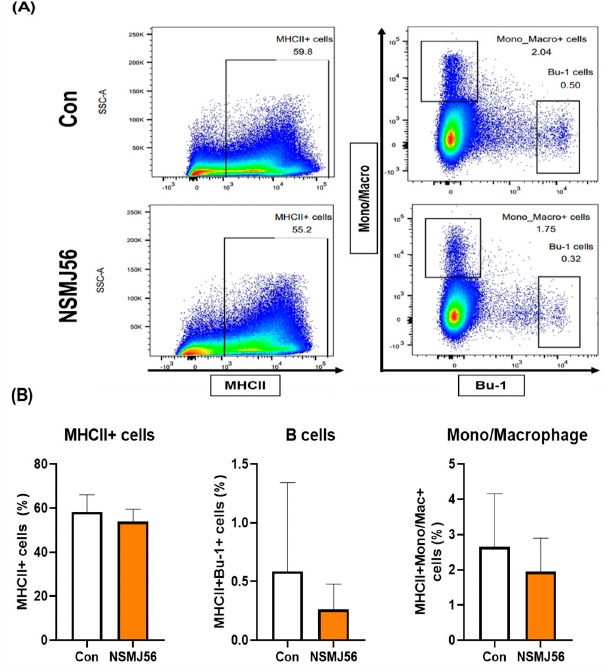
Figure 2. Changes in antigen-processing cells in the intestine by NSMJ56 feeding. Broilers were fed a control diet or an NSMJ56-containing diet for 10 days. Proportions of MHC II+ cells, B cells, and monocyte/macrophages were analyzed by flow cytometry in the 10-day-old broilers. A representative dot plot is shown ( A ) and immune cell distribution is presented ( B ). Data were obtained from the control group ( n = 10) and NSMJ56 group ( n = 7) and presented as means ± SD. Significant differences between the control and NSMJ56 groups were analyzed by a two-tailed unpaired t-test or Mann–Whitney test.